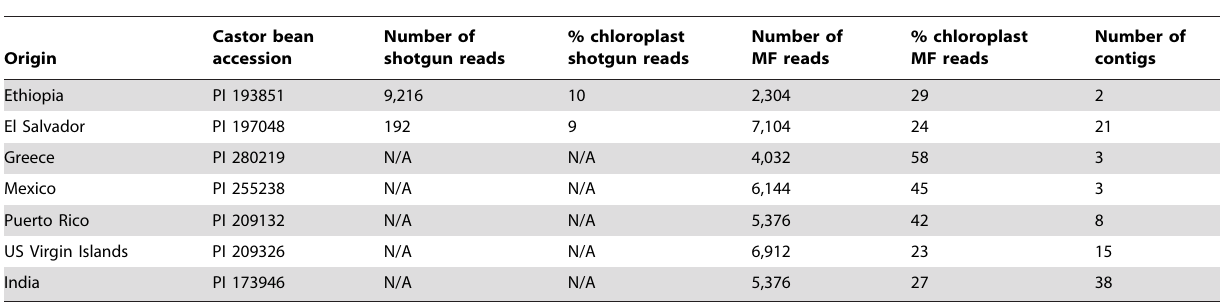
Table 1. MF and WGS sequencing of 7 additional castor bean